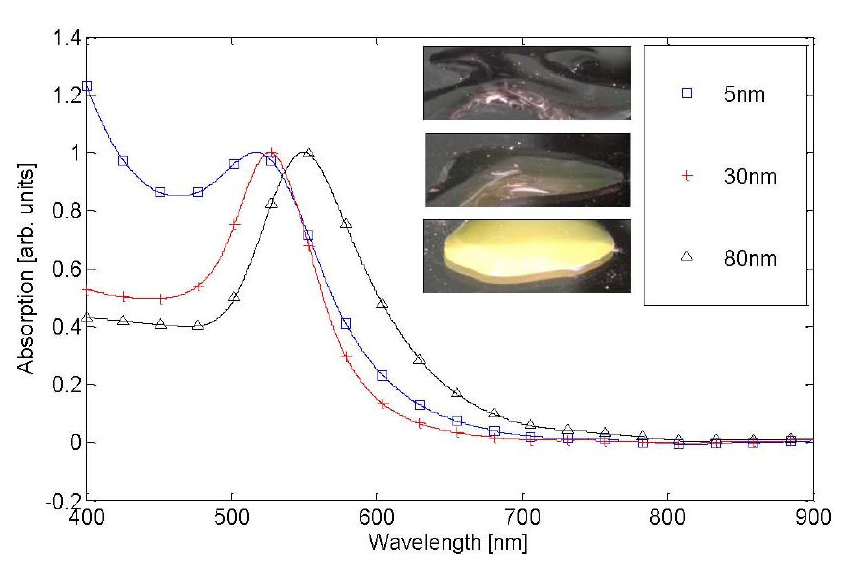
Figure 4. Measured absorption spectra of gold